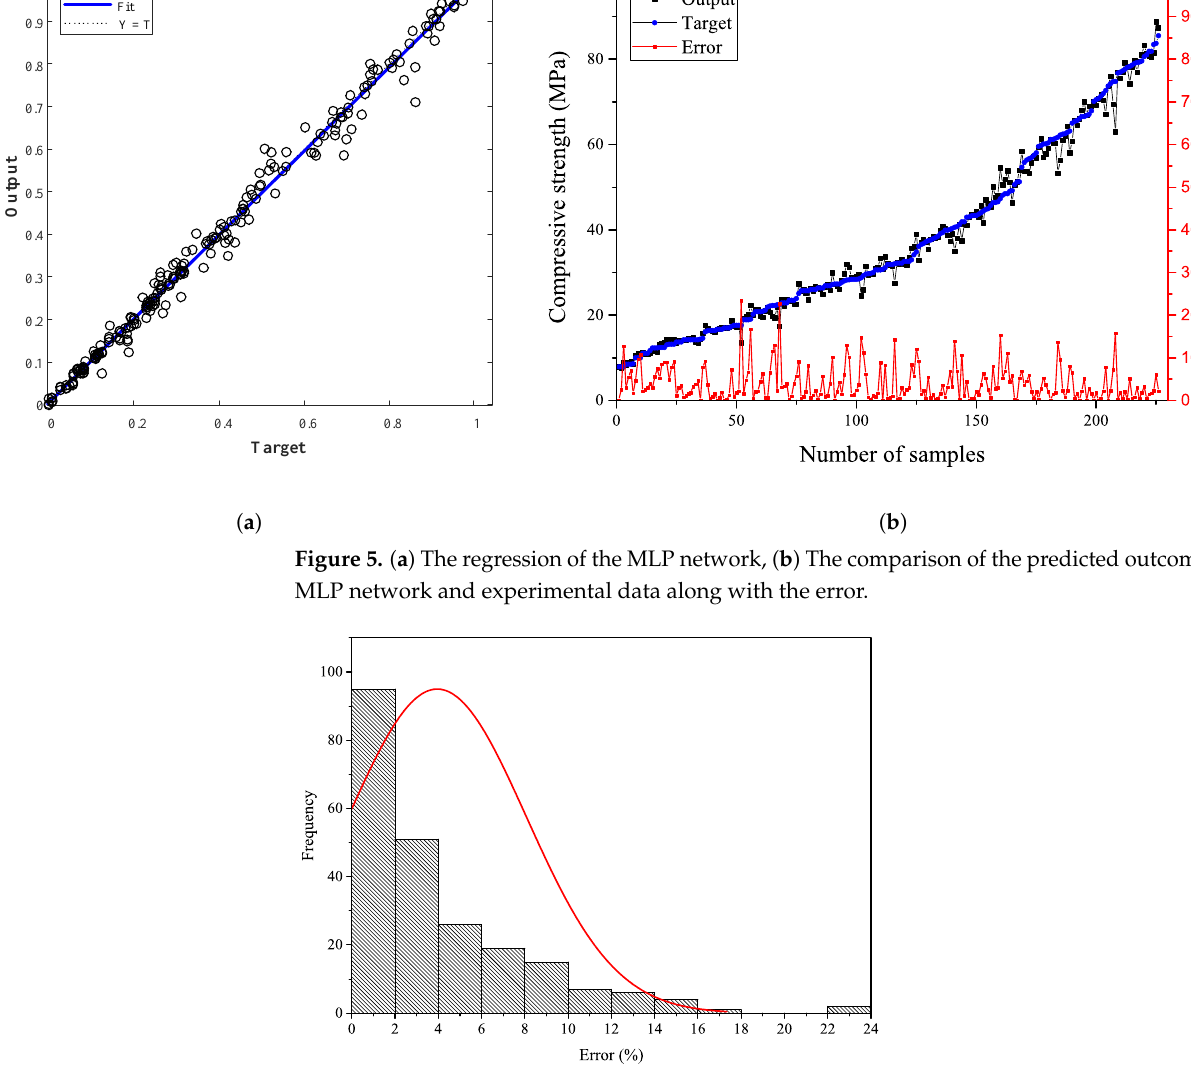
Figure 6. The histogram of error along with distribution curve. The statistical error values for the estimated compressive strength of concrete con- taining binary SCMs obtained from the MLP network are described as root mean square error (RMSE), Nash–Sutcliffe efficiency (NSE) coefficient, mean absolute percentage error (MAPE), and correlation coefficient (R). The aforementioned statistical measures can be calculated using Equation (1). These statistical indicators, including MSE, are compared in Table 7 according to all data points. Zero or near to zero are ideal values for all statistical parameters, except for NSE and R, while the ideal value for NSE and R is one. RMSE stipulates the deviation between the experimental results and estimated outcomes of the MLP network. Both the estimation error and the ratio of the error to the experimental value are reflected in MAPE [39,47]. Assessment of the estimation capability of the MLP network is determined using the NSE coefficient. The statistical metrics in Table 7 show that the results of the MLP network in estimating the compressive strengths of concrete containing binary SCMs are close to the experimental results in a satisfactory manner. This further validates the acceptability of the proposed MLP